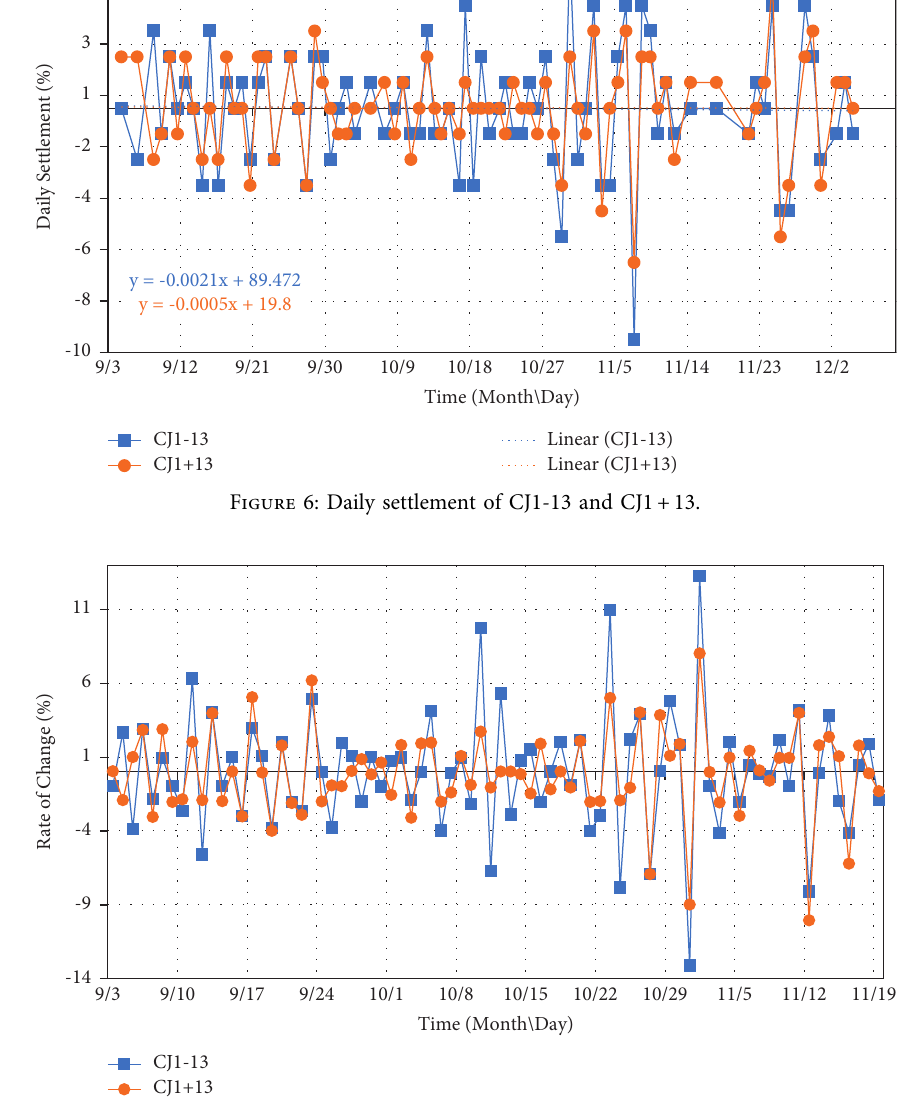
Figure 7: Rate of change of daily settlement (CJ1-13 and CJ1